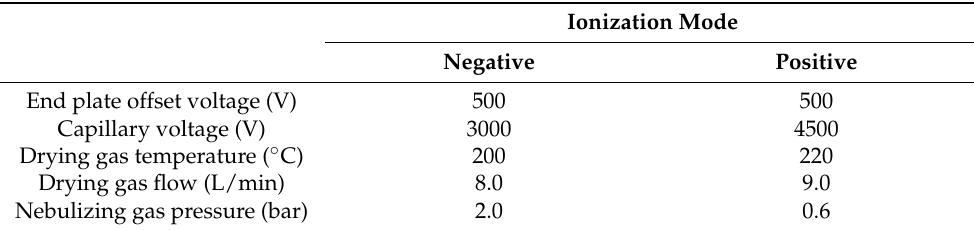
Table 3. Source and tune